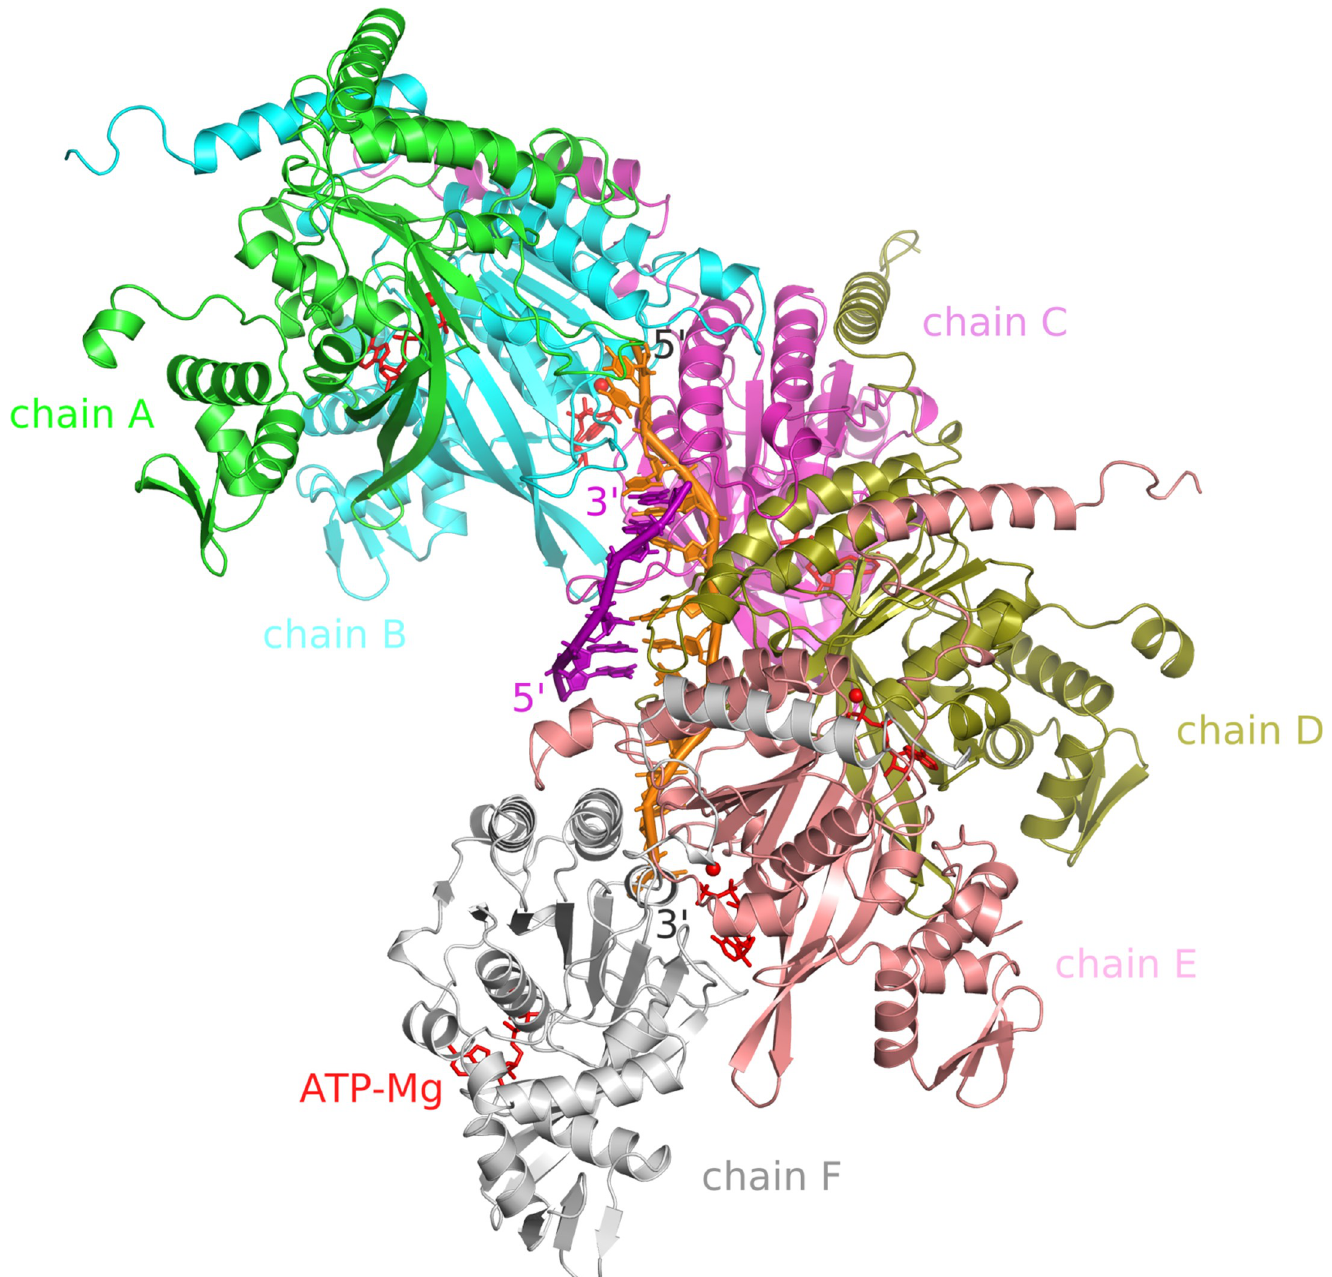
Fig 4. Model for HsRecA-ATP-dsDNA hexamer. The complete model of HsRecA hexamer (shown in cartoons, one different color for each monomer) containing dsDNA (shown as orange and purple sticks), ATP (shown as red sticks) and magnesium ions (shown as red spheres).